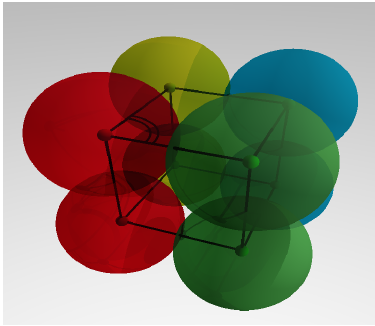
Structural template. Example of a structural template, showing a cube shaped assembly composed of eight elementary molecules . As a rigid body, this structure will keep its shape during the whole length of the